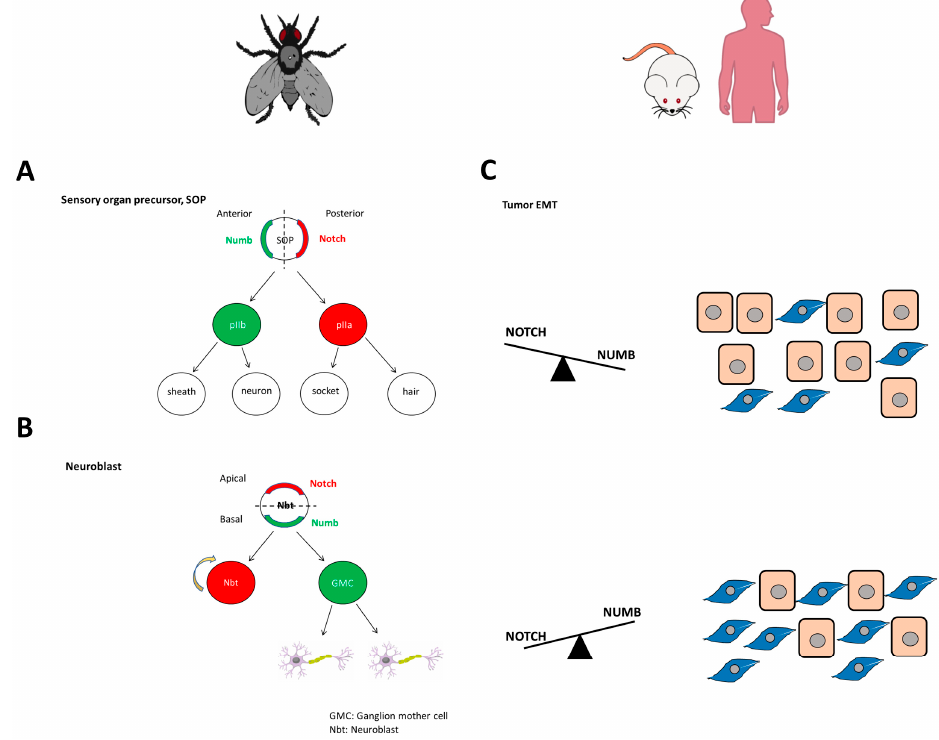
Figure 2. ( A ) NUMB and NOTCH are asymmetrically distributed to daughter cells during SOPs in Drosophila . ( B ) NUMB and NOTCH are involved in determining cell fate in Dro- sophila neuroblasts. The cell that inherits NOTCH (Neuroblast) has self-renewal proper- ties, while the cell that inherits NUMB (GMC: ganglion mother cell) is able to differentiate into neurons. ( C ) The balance of NUMB and NOTCH is also thought to be involved in EMT in mice and humans tumors. Increased NUMB expression relative to NOTCH has been shown to reduce EMT, while increased NOTCH levels can increase